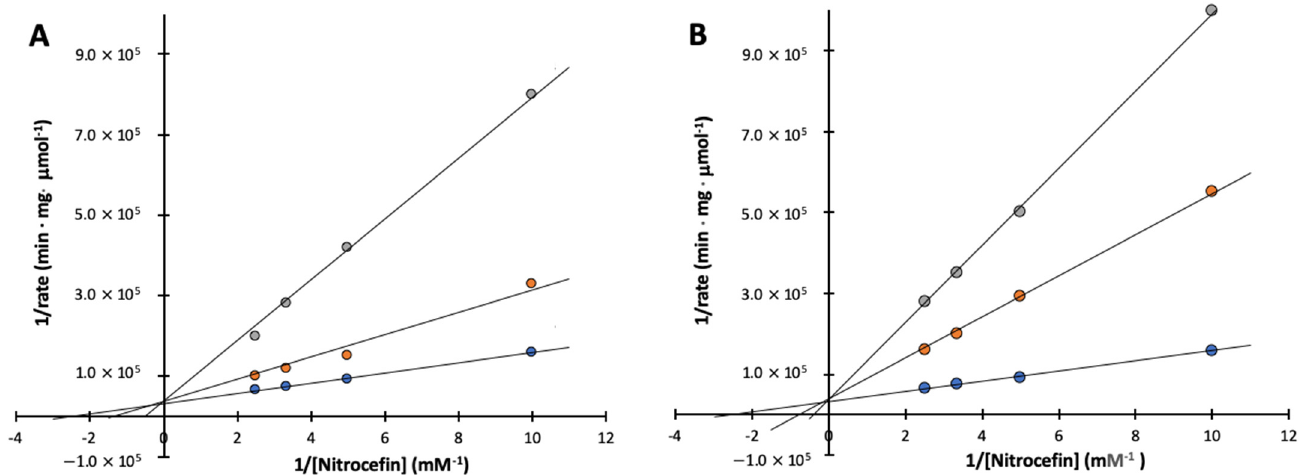
Figure 5. Lineweaver–Burk plots of inhibition of Bla2 by Compound 4 and 6 . Assays were performed in 50 mM MOPS, pH 7.0. Kinetic constants were determined by fitting of the data to the equation v = V max · S/(K m · (1 + 1/K i ) + S) which indicates competitive inhibition. ( A ) The concentrations of compound 4 are 0 (blue), 6 (orange), and 30 µ M (gray); ( B ) The concentrations of compound 6 are 0 (blue), 10 (orange), and 30 µ M (gray). All data points are based on average values from triplicate